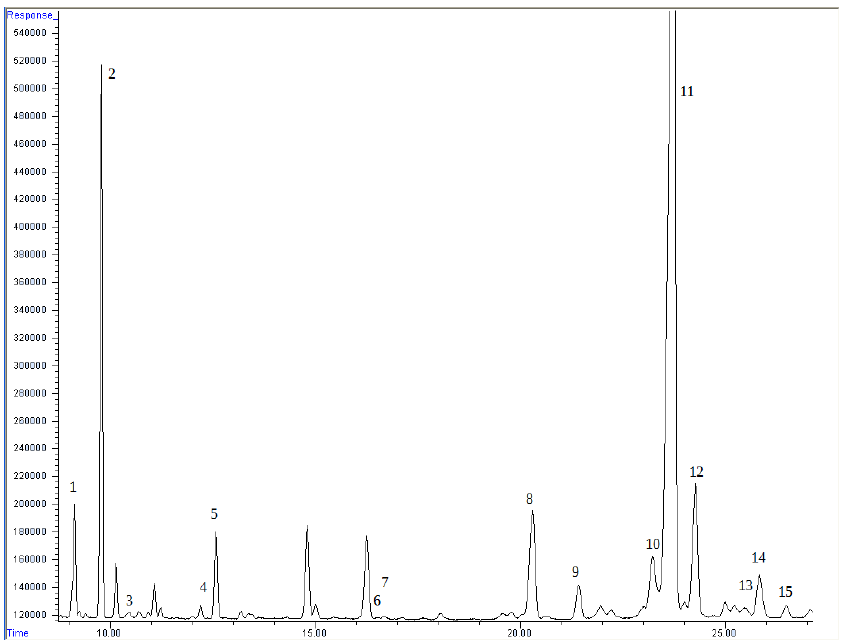
Figure 1. Chromatogram of detected lipid-soluble substances. 1: squalene; 2: 5-alpha-cholestan (internal standard); 3: delta-tocopherol; 4: beta-tocopherol; 5: gamma-tocopherol; 6: alpha-tocopherol; 7: cholesterol; 8: campesterol; 9: stigmasterol; 10: clerosterol; 11: beta-sitosterol; 12: d5-avenasterol; 13: 5,24-stigmastadienol; 14: 7-stigmastenol; 15: d7-avenasterol.